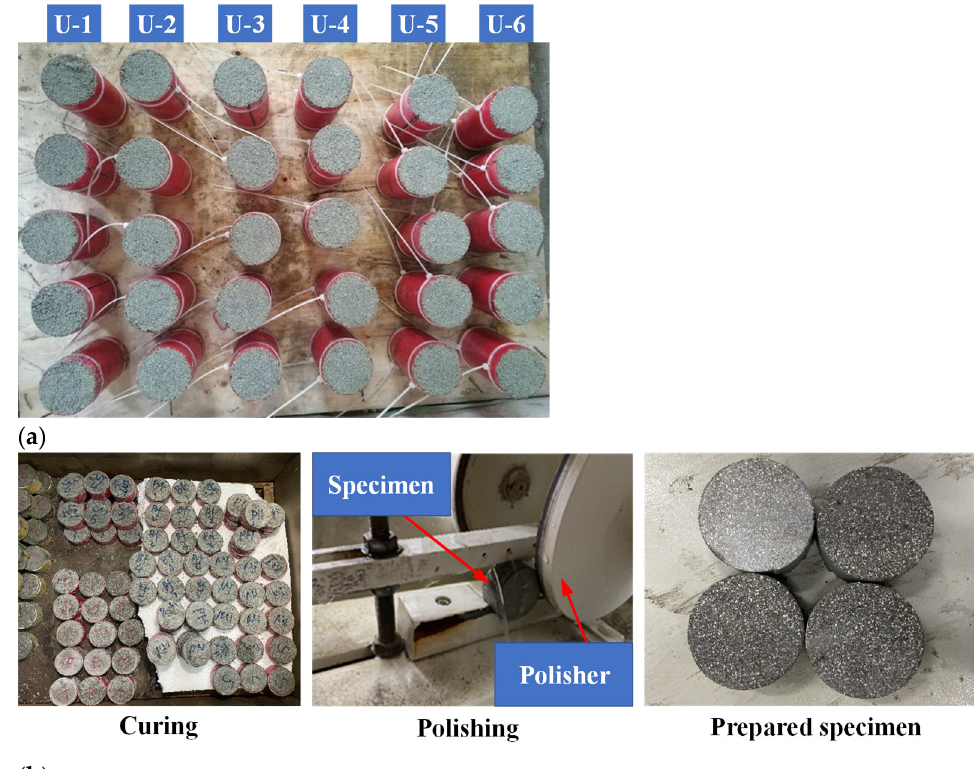
Figure 3. Prepared CCS specimens: ( a ) typical specimens for UCS tests; ( b ) specimens for the SHPB tests.